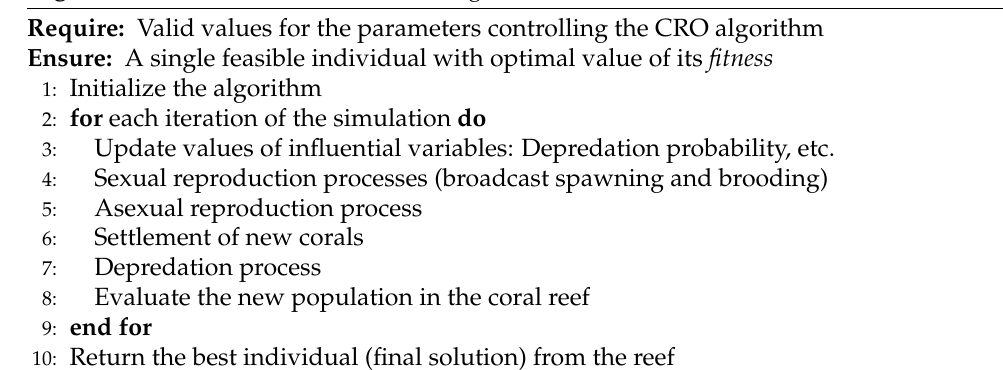
Algorithm 1 Pseudocode for the CRO algorithm.